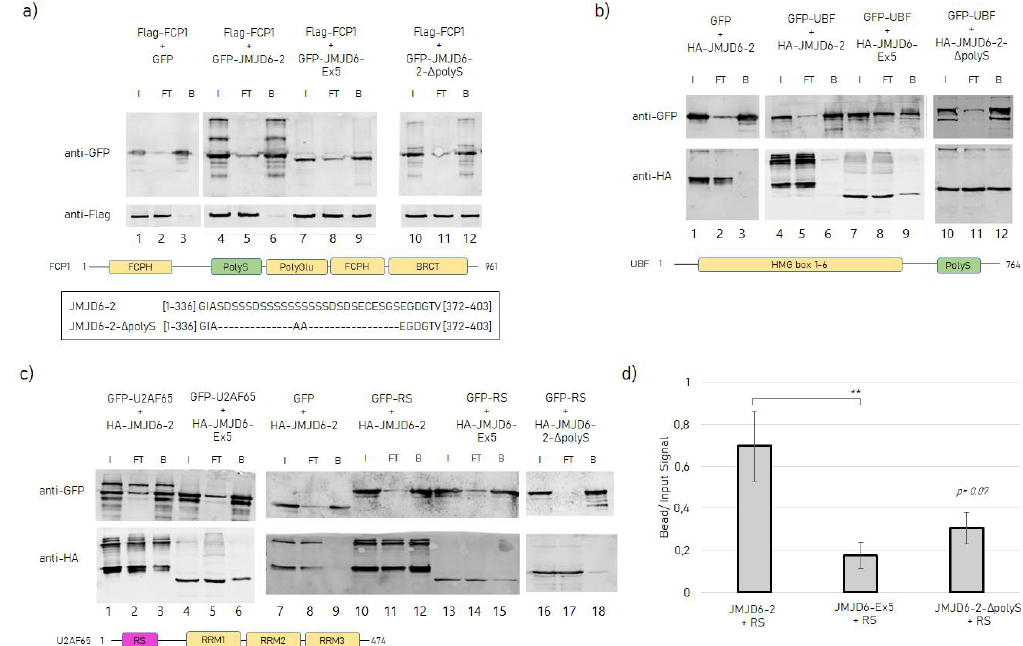
Figure 4. Co-immunoprecipitation experiments for interactions of JMJD6 variants with FCP1, UBF, U2AF65 and U2AF65- arginine / serine-rich (RS)-domain only, performed in HEK 293T cell lysates 48 h after transfection of respective plasmids; Input (I), flow-through (FT) and bound on beads (B) fractions are shown after SDS-PAGE and Western Blotting. Western Blots were stained with antibodies as indicated on the left-hand side of the Blots. ( a ) Flag-tagged FCP-1 and GFP-tagged JMJD6 variants; Bottom part shows a schematic presentation of the protein structure of FCP1 with its serine-rich region highlighted in green (PolyS). Underneath is the sequence of polyS-domain in JMJD6-2 in comparison with mutant JMJD6-2- ∆ polyS. ( b ) GFP-tagged UBF and HA-tagged JMJD6 variants; Bottom part shows a schematic presentation of the protein structure of UBF with its serine-rich region highlighted in green (PolyS). ( c ) GFP-tagged U2AF65 and HA-tagged JMJD6 variants plus GFP-tagged RS-domain of U2AF65 (U2AF65 20-70 , RS) and HA-tagged JMJD6 isoforms. Bottom part shows a schematic presentation of the protein structure of U2AF65 with its arginine- and serine-rich region highlighted in pink (RS). ( d ) Ratio between band intensity of input and bead signal from IPs ( n = 7) with JMJD6-2, JMJD6-Ex5 and JMJD6-2- ∆ polyS and GFP-RS, analyzed with ImageJ. Mean values ± SEM are presented and a t-test was conducted (** p < 0.01).